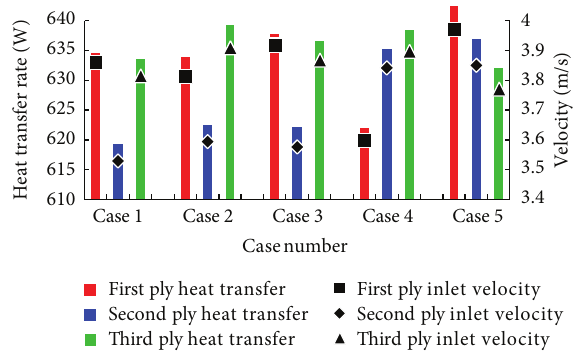
Figure 4: Variation of heat transfer rate with respect to inlet velocity at 2.5 L/min in various cases.